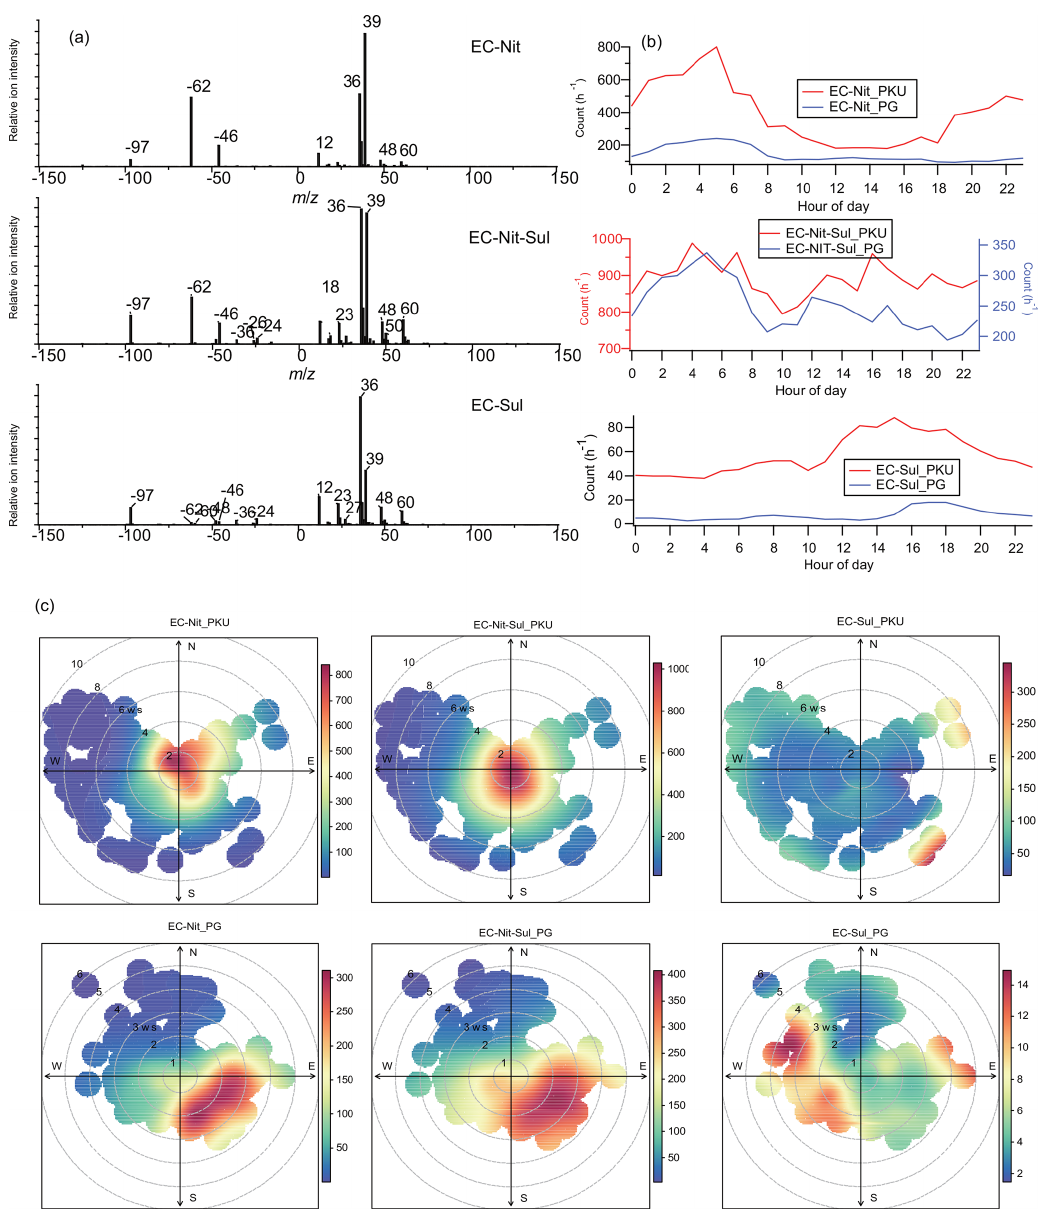
Figure 3. (a) Average mass spectra of EC-Nit, EC-Nit-Sul, and EC-Sul at both sites; (b) diurnal patterns of EC-Nit, EC-Nit-Sul, and EC-Sul at both sites; (c) polar plots of EC-Nit, EC-Nit-Sul, and EC-Sul; the gray circles indicate wind speed (ms 1